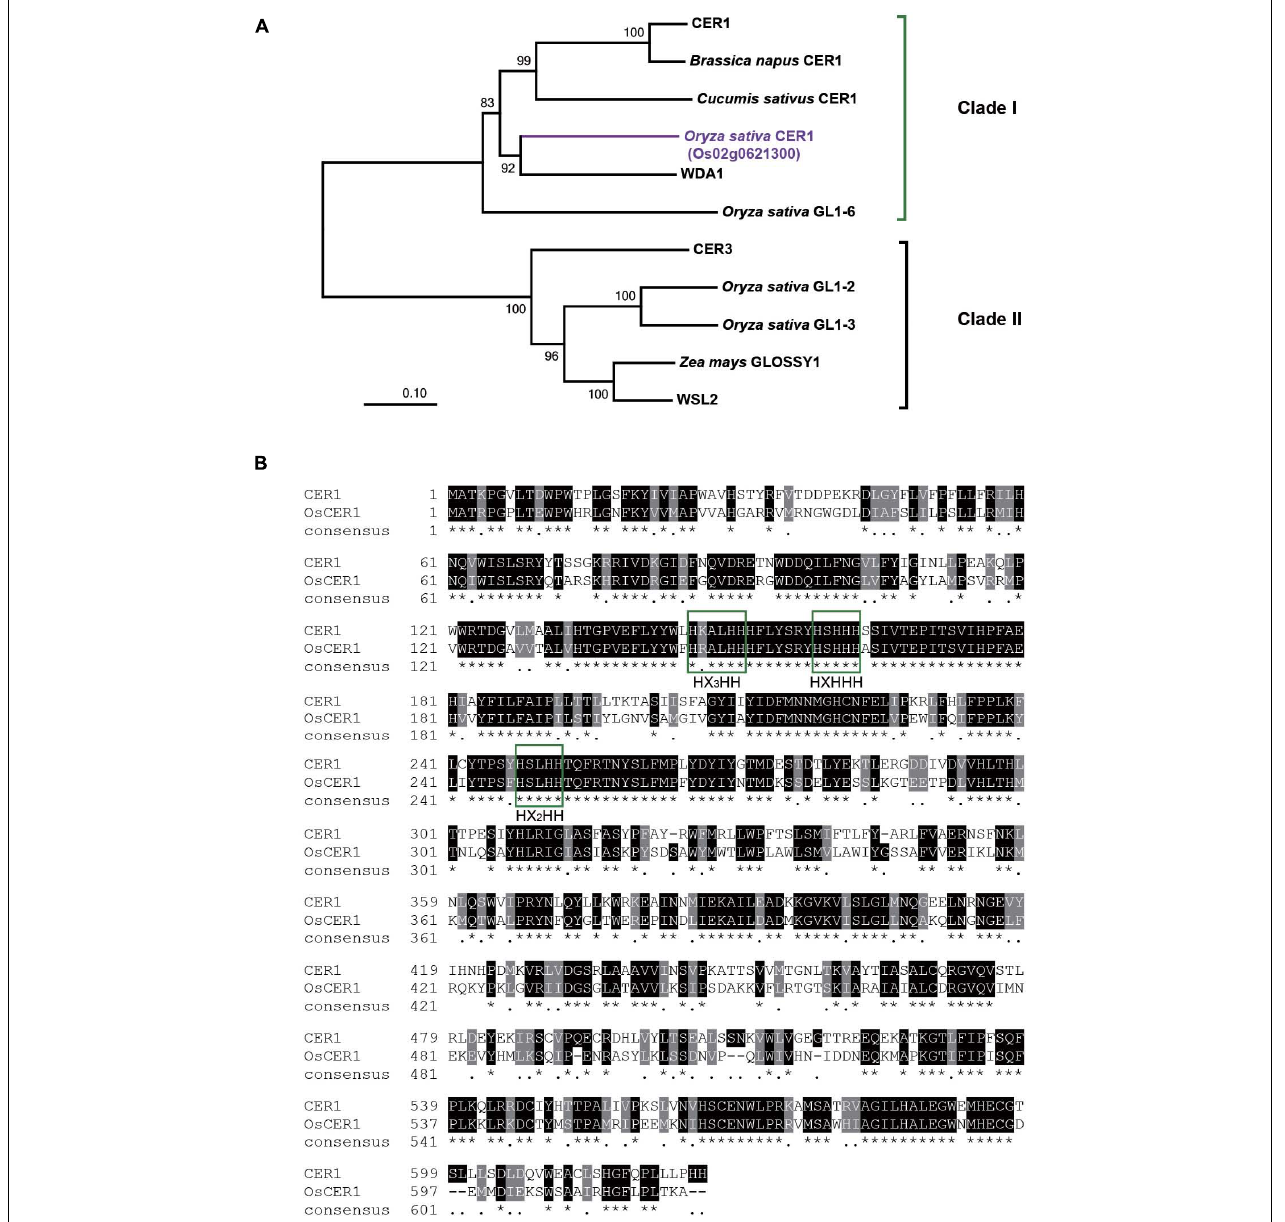
FIGURE 1 | Phylogenic analysis and sequence alignment of OsCER1. (A) Phylogenetic analysis of the OsCER1 protein and 10 OsCER1 related proteins. Bootstrap values are shown on the branches. The scale bar represents the number of amino acid substitutions per site. The value of 0.01 on the scale bar indicates 1 amino acid substitution per 100 residues. The numbers near the branches refer to the bootstrap value of the neighbor-joining phylogenetic tree. The length of the branches is proportional to the amino acid variation rates. (B) Sequence alignment between CER1 and OsCER1. Identical and similar residues are shown on black and gray backgrounds, respectively. Green boxes indicate the three conserved active His-rich motifs; asterisks ( ∗ ) indicate the identical residues in all sequences, black dots (.) indicate the semi-conserved substitutions, and dashes (–) indicate gaps in the